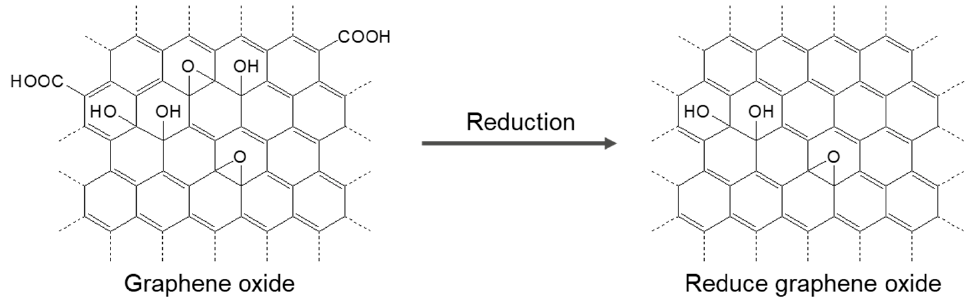
Figure 3. Chemical structure of GO and reduced GO produced after reduction.